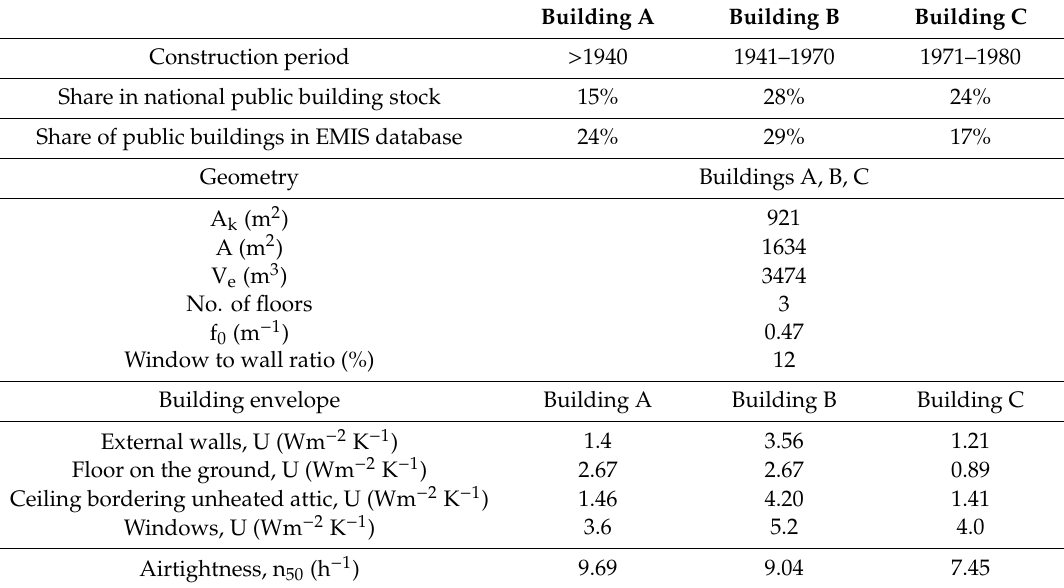
Table 2. The main characteristics of the case studies in the initial